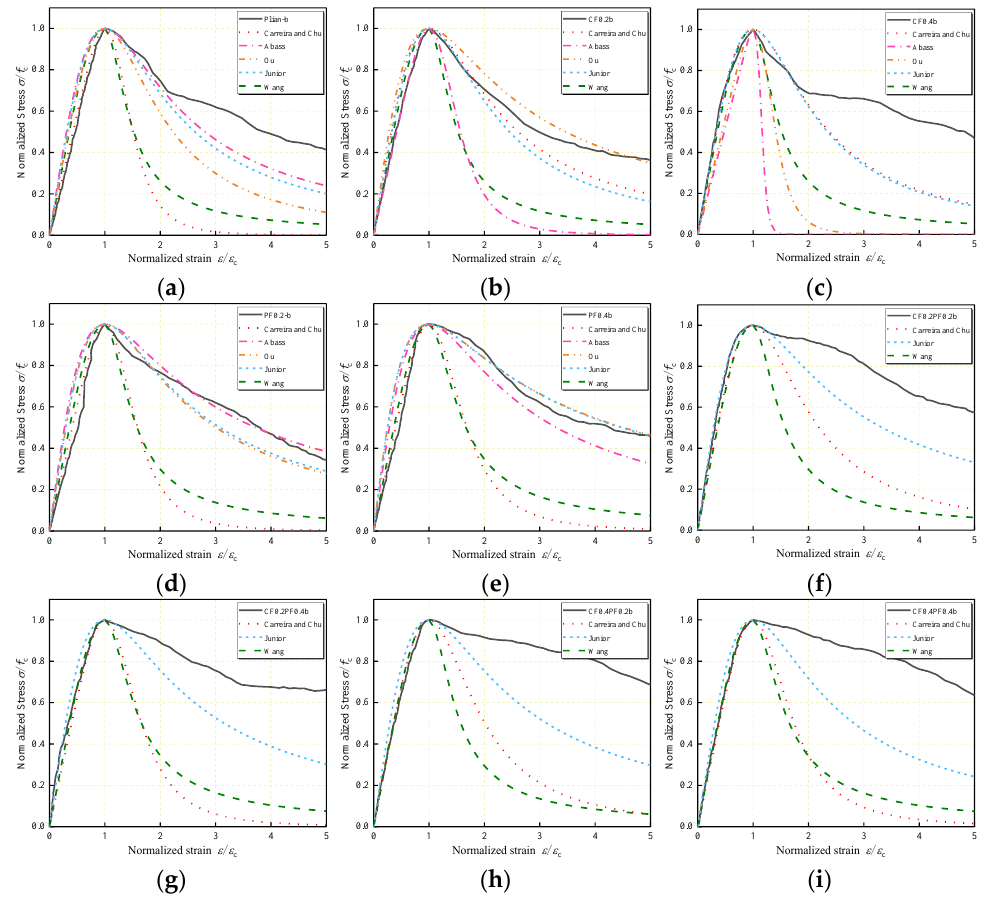
Figure 9. Application of existing stress – strain models to the data of: ( a ) Plain – a; ( b ) CF0.2a; ( c ) CF0.4a; ( d ) PF0.2a; ( e ) PF0.4a; ( f ) CF0.2PF0.2a; ( g ) CF0.2PF0.4a; ( h ) CF0.4PF0.2a; ( i ) CF0.4PF0.4a.